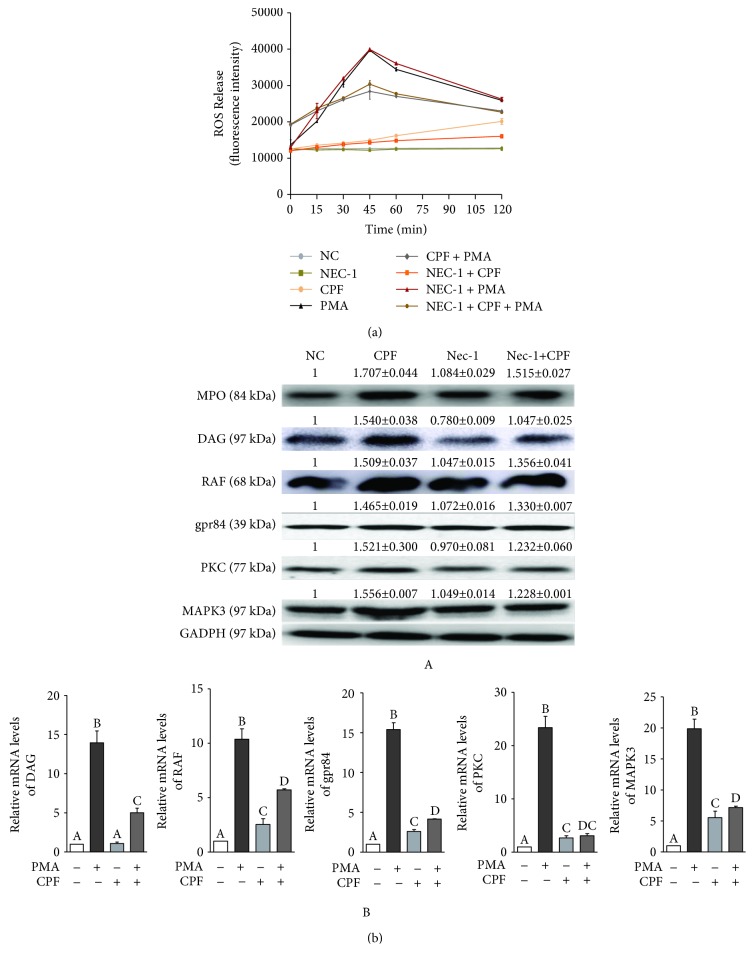
ROS levels, protein levels of MPO, and the mRNA and protein levels of the PKC-MAPK pathway components in neutrophils (a) Effects of PMA and/or CPF and/or Nec-1 on the release of ROS. (b) The protein levels of MPO and the mRNA and protein levels of the genes related to the PKC-MAPK pathway. The experiments were repeated three times. The data are presented as the mean ± SD. The samples with different letters were considered significantly different (P < 0.05). The samples with the same letters were not significantly different (P > 0.05).